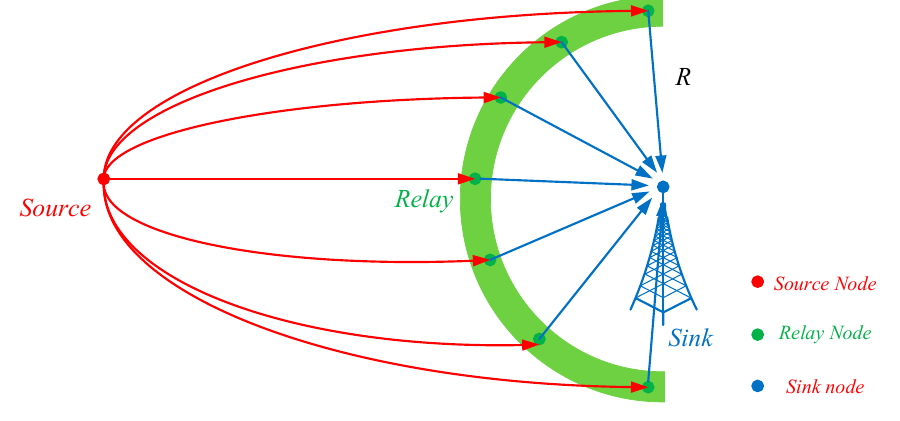
Figure 6. The possible area of the relay nodes.